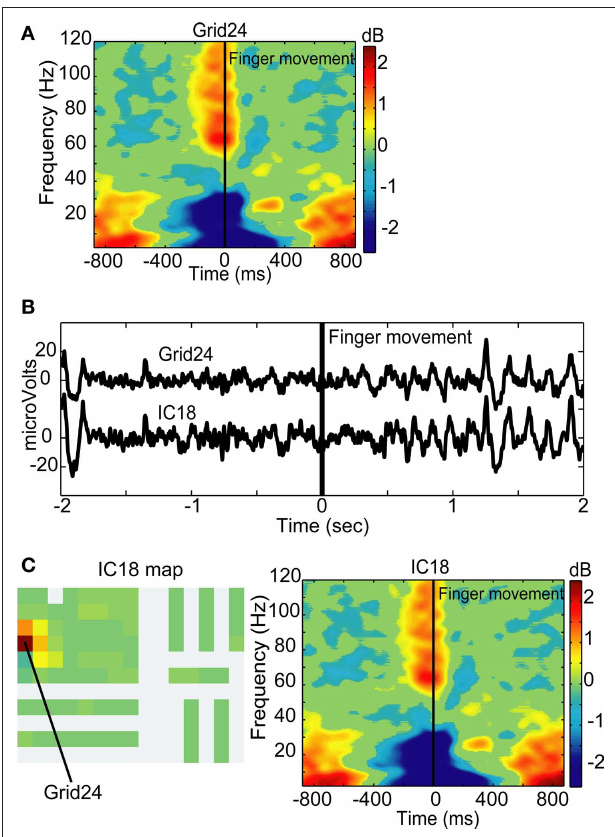
FIGurE 9 | Mu blocking and movement-related spectral dynamics. (A) Trial-average event-locked log power spectrum for Grid24, an electrode in or near primary motor cortex (compare C). (B) Time series of Grid24 and IC18 from an example 2-s segment including the finger movement (at 0 ms). Suppression of mu began approximately 1.7 s before the movement and lasted until 0.5 s after movement onset. (C) Component map and trial-average event-locked log power spectrum for IC18. The grid map of IC18 maximally back-projects to Grid24 with smaller projections to neighboring channels. IC18 shows strong gamma increase during the movement and concurrent power decreases in both the beta and alpha power